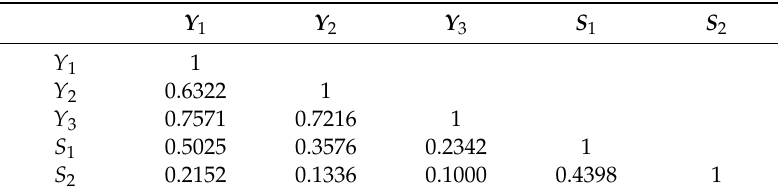
Table 2. Pearson’s correlation matrix of Y 1 , Y 2 , Y 3 , S 1 , S 2 .